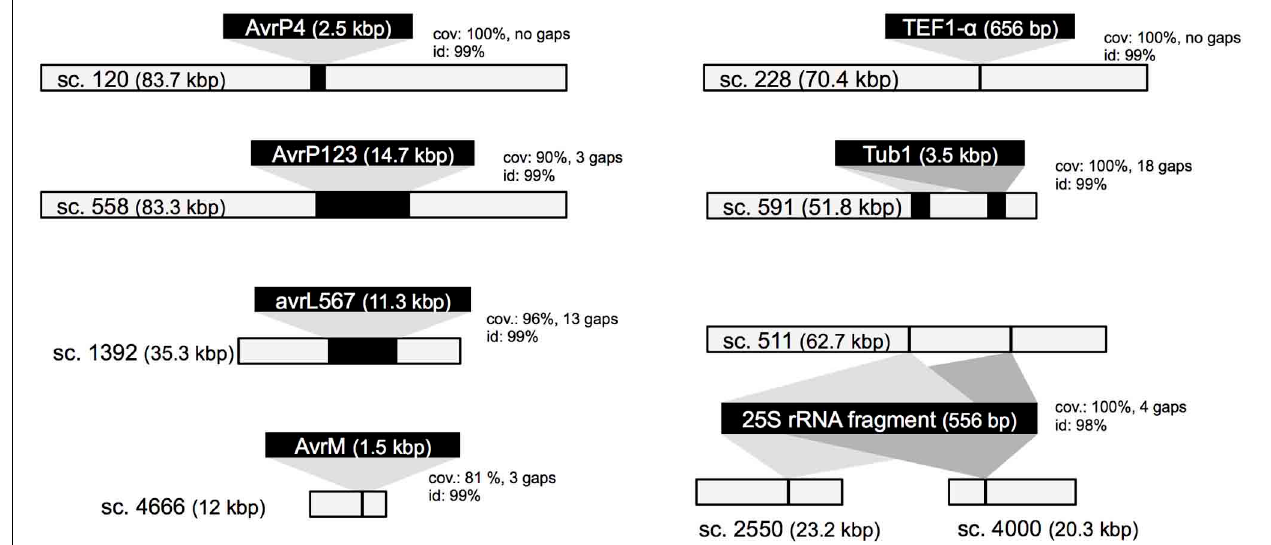
FIGURE 1 | Validation of the M. lini isolate CH5 genome assembly. Seven previously sequenced genomic loci were used as controls (black bars with text, not in scale). They were aligned to scaffolds from the de novo assembly.